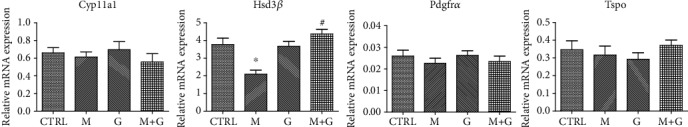
Gene expression of Leydig cell markers. ∗Significantly different from CTRL at P < 0.05; #significantly different from group M at P < 0.05.